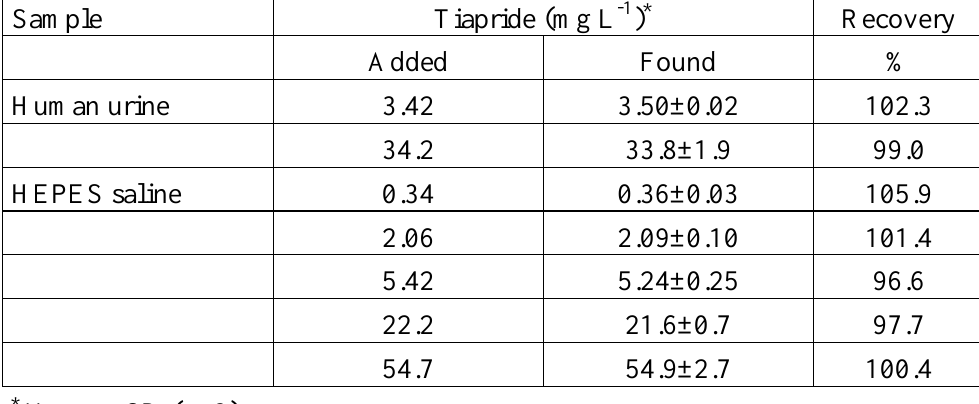
Table 4. Determination of tiapride hydrochlorhide in different